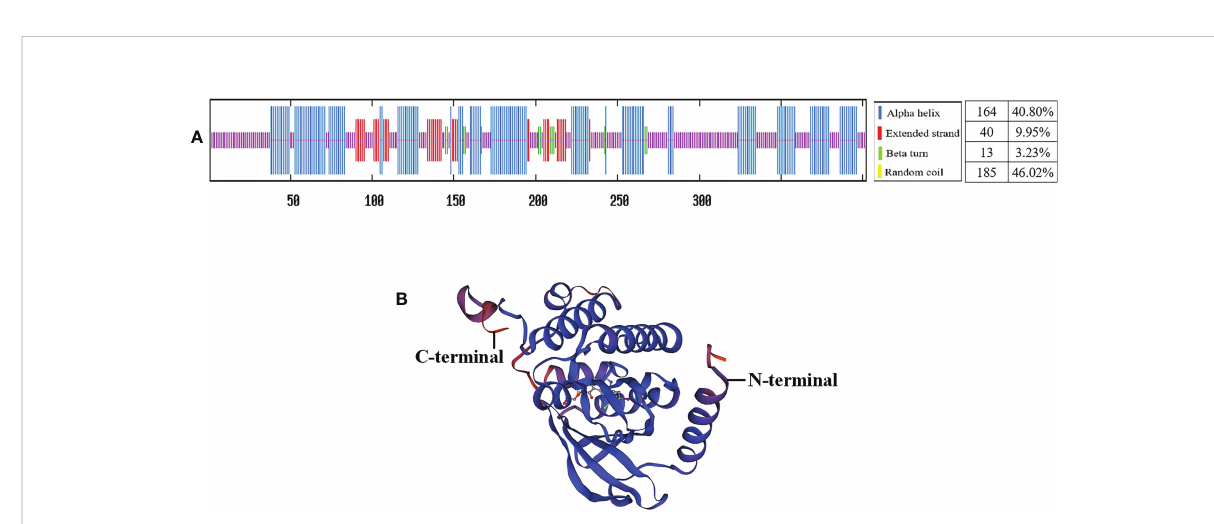
FIGURE 3 The SNPS in the conserved domains of AiiMEK1 and ApuMEK1 . Sequences were highlighted with a yellow shading indicates the region of S_TKc in AiiMEK1 and ApuMEK1. The purple box indicates the ATP-binding site, and blue box indicates the activation site of S_TKc.